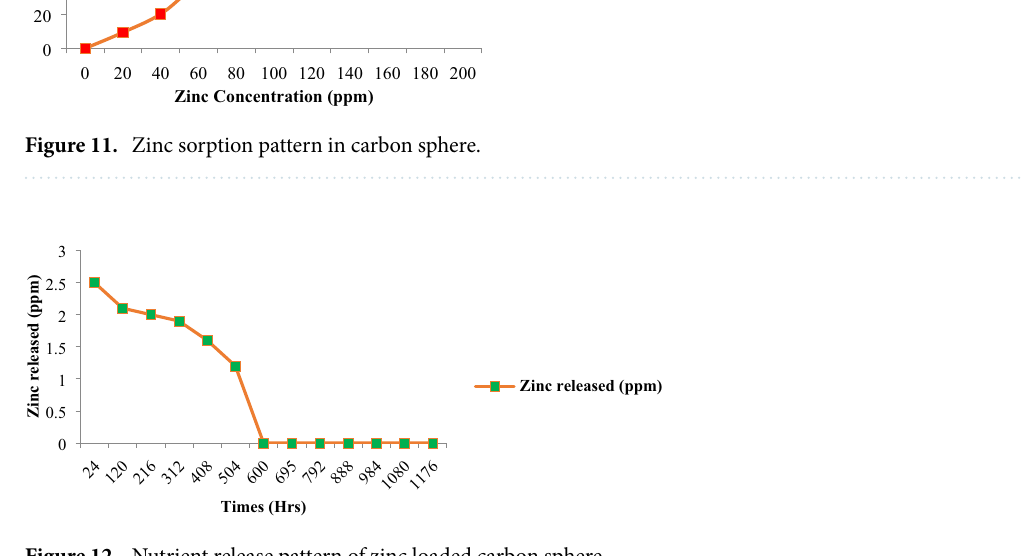
Figure 12. Nutrient release pattern of zinc loaded carbon